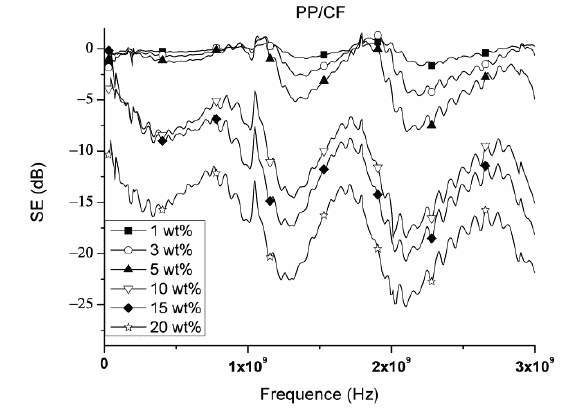
Figure 11. EMI SE of PP/CF composites with a thickness of 0.5 mm as related to various blending